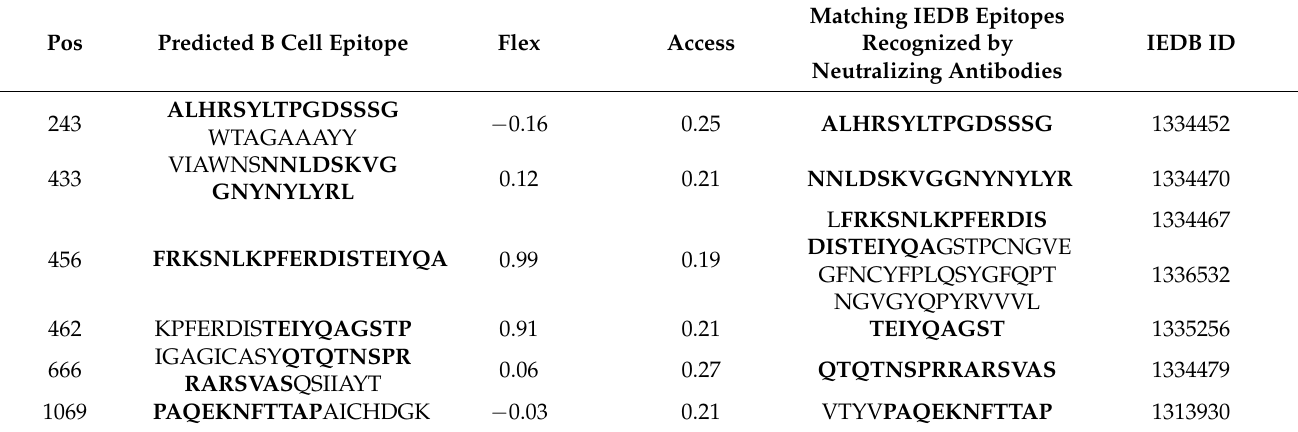
Table 3. B cell epitopes predicted by BCEPS matching known neutralizing B cell